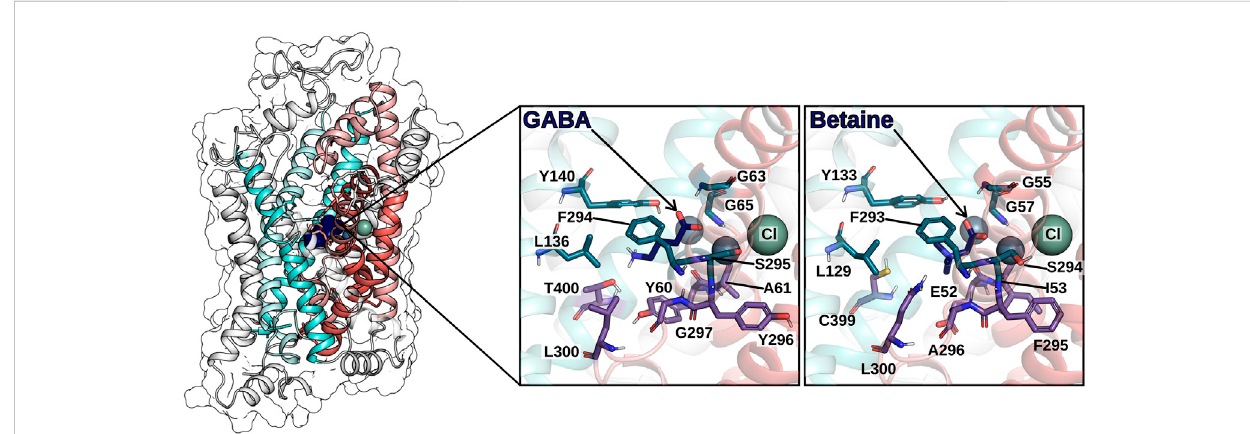
hGAT1 is shown in ribbon representation and in transparent surface rendering. The coloring scheme follows Figure 4: TM helices of the scaffold domain are shown in cyan colors, the TM helices of the bundle domain in red colors. GABA (in the S1) is shown by dark blue van der Waals rendering. The zoom-inpanelshighlighttheresiduesonthesurfaceoftheS1fortheGABAboundGAT1andthebetaineboundBGT-1,respectively.Spheresindicatethe sodium ions (grey-blue) and the chloride ion